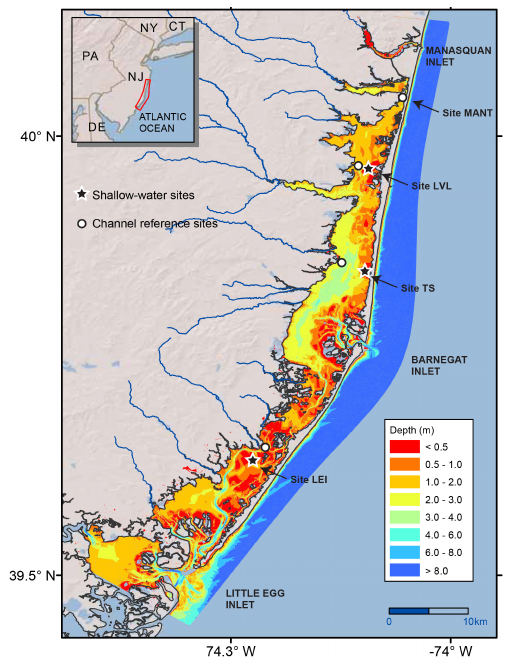
Figure 1. Map of Barnegat Bay, on the New Jersey Atlantic coast. Shoal sites are marked with a star; channel sites are marked with a circle. Estuarine bathymetry is from recent USGS mapping (unpub-